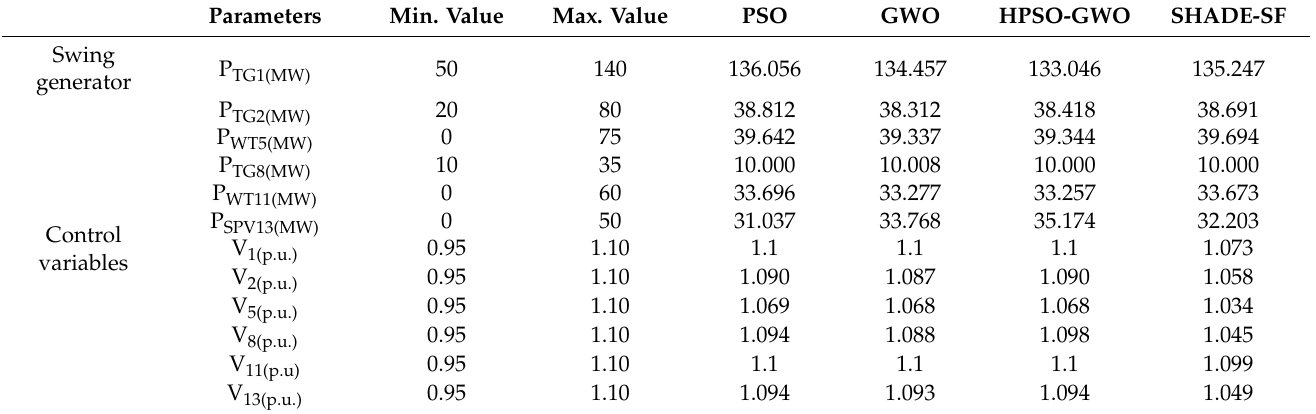
Table 5. Simulation results for Case